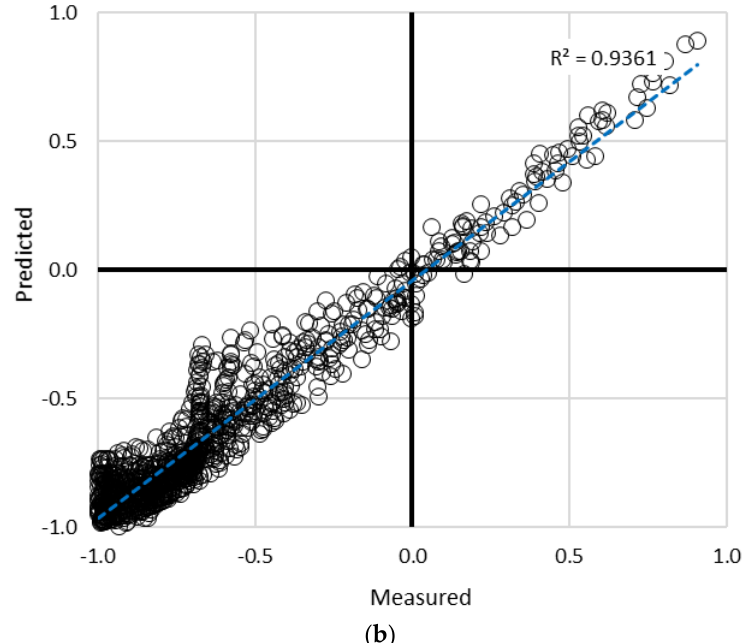
Figure 13. Training and testing outcomes form ANN model in estimating F ult (e.g., with eight nodes). ( a ) ANN-training dataset, ( b ) ANN-testing dataset